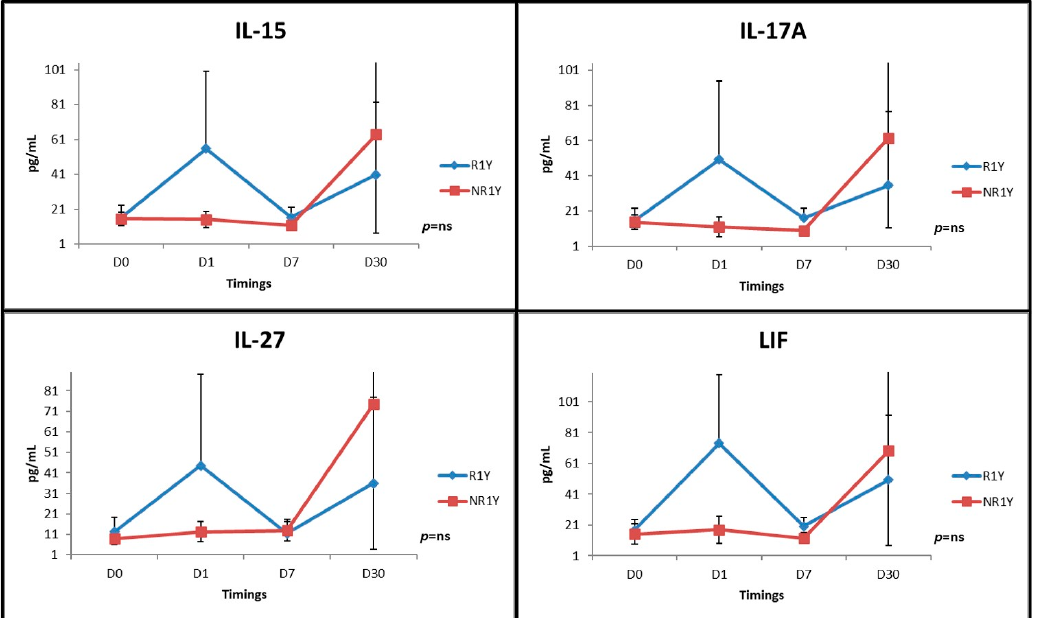
Figure 3. Significant variation in time was observed when analyzing IL-15, IL-27, IL-17A, and LIF at four time points (D0, D1, D7, and D30), with responders presenting an acute rise 24 h after RDN. Panels indicate values between R1Y and NR1Y. The same pattern is maintained when analyzing response at six months (not shown). Data are presented as mean ± standard deviation.